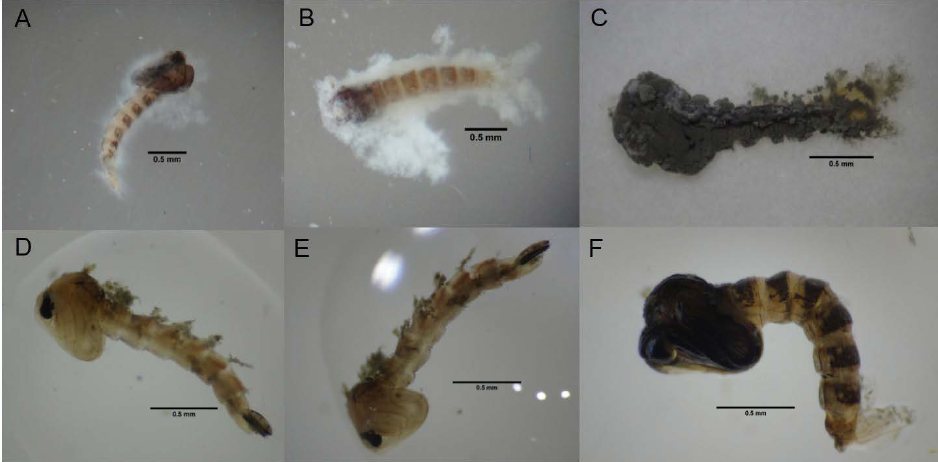
Fig. 2. Blastospores infecting Aedes aegypti pupae with copious amounts of mucilage secreted by the fungus (A and B). After infection by blastospores, conidial sporulation was observed on dead pupae (C). Pupae infected with Metarhizium anisopliae conidia showed no mucilage production and no sporulation was observed on the insect integument (D -